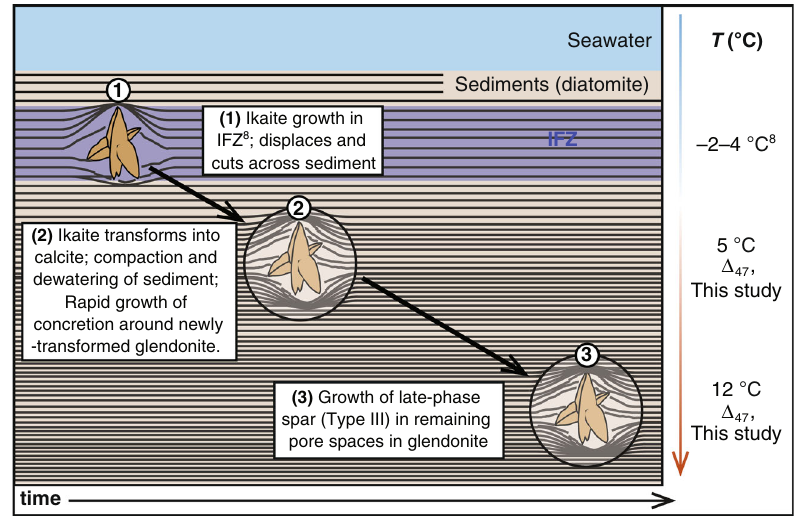
Fig. 6 Model for ikaite growth and transformation to glendonite. This model is based on Zhou et al. 8 , Lu et al. 11 and Vickers et al. 12 ; clumped and stable isotopic and minor element analysis, and visual and microscopic observations on the Fur Formation glendonites (this